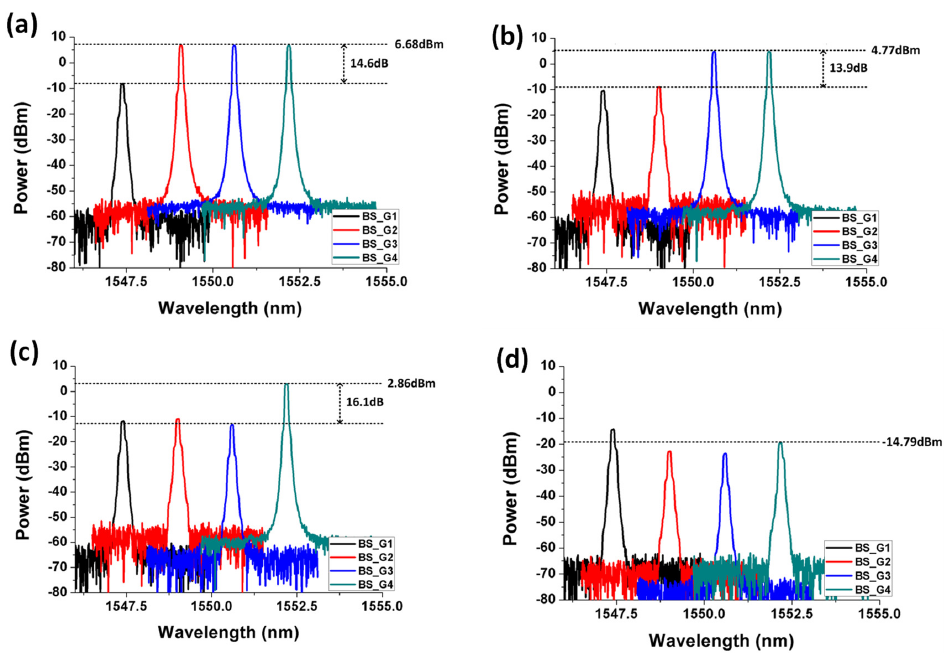
Figure 2. Spectrum of downlink light signals after penetrating ( a ) SBOADM1, ( b ) SBOADM2, ( c ) SBOADM3 and ( d ) SBOADM4.